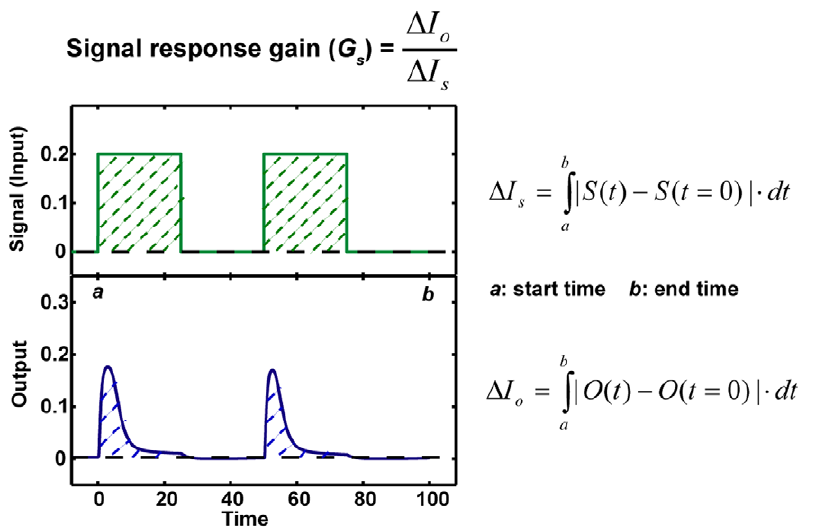
Figure 5. Schematic description of signal response gain ( G s ). The integral change of signal input ( D I s ) corresponds to the area formed by the signal input curve and the basal line of signal input. The integral change of signal output ( D I o ) corresponds to the area formed between signal output response curve and the basal line of signal output. The signal response gain is defined as the ratio of D I o to D I s .